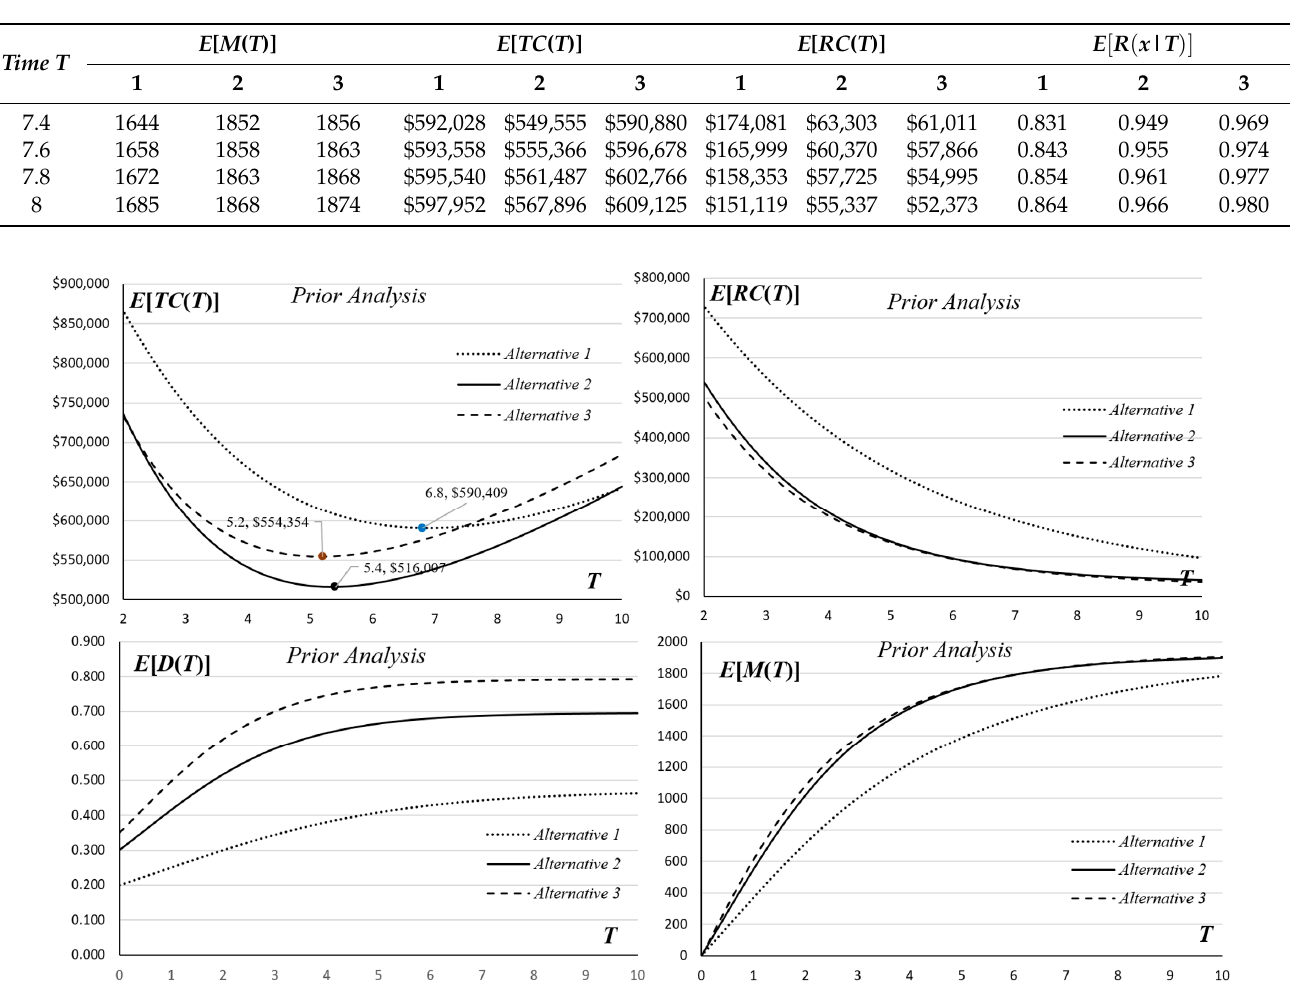
Figure 8. The comparisons among alternatives 1, 2, and 3 on 𝐸[𝑇𝐶(𝑇)] , 𝐸[𝑅𝐶(𝑇)] , 𝐸[𝐷(𝑇)] and 𝐸[𝑀(𝑇)] .